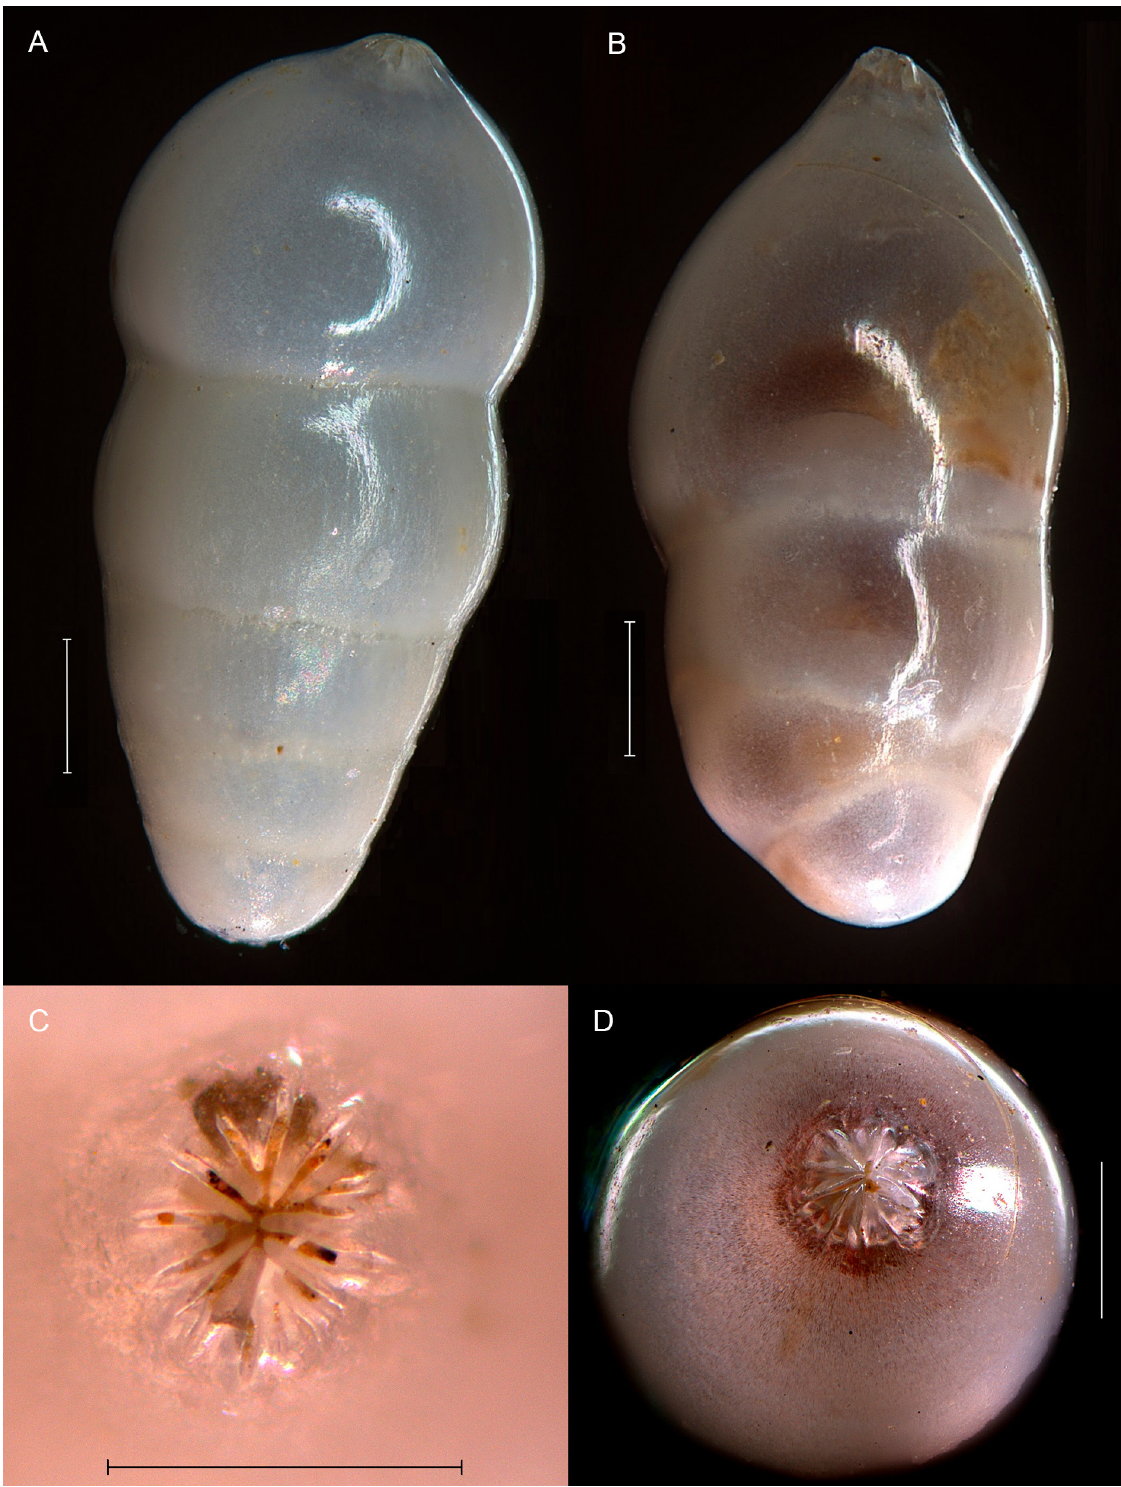
Fig. 15. Pseudonodosaria subannulata (Cushman, 1923). A, C . Megalosphere (BIOICE 2869, IIHN40054), specimen with nearly horizontal sutures (A) and aperture (C). B, D . Megalosphere (BIOICE 2856, IIHN40017), specimen with irregularly slanted sutures (B) and aperture (D). Light source combination of incident light and dark field. Scale bars = 0.25